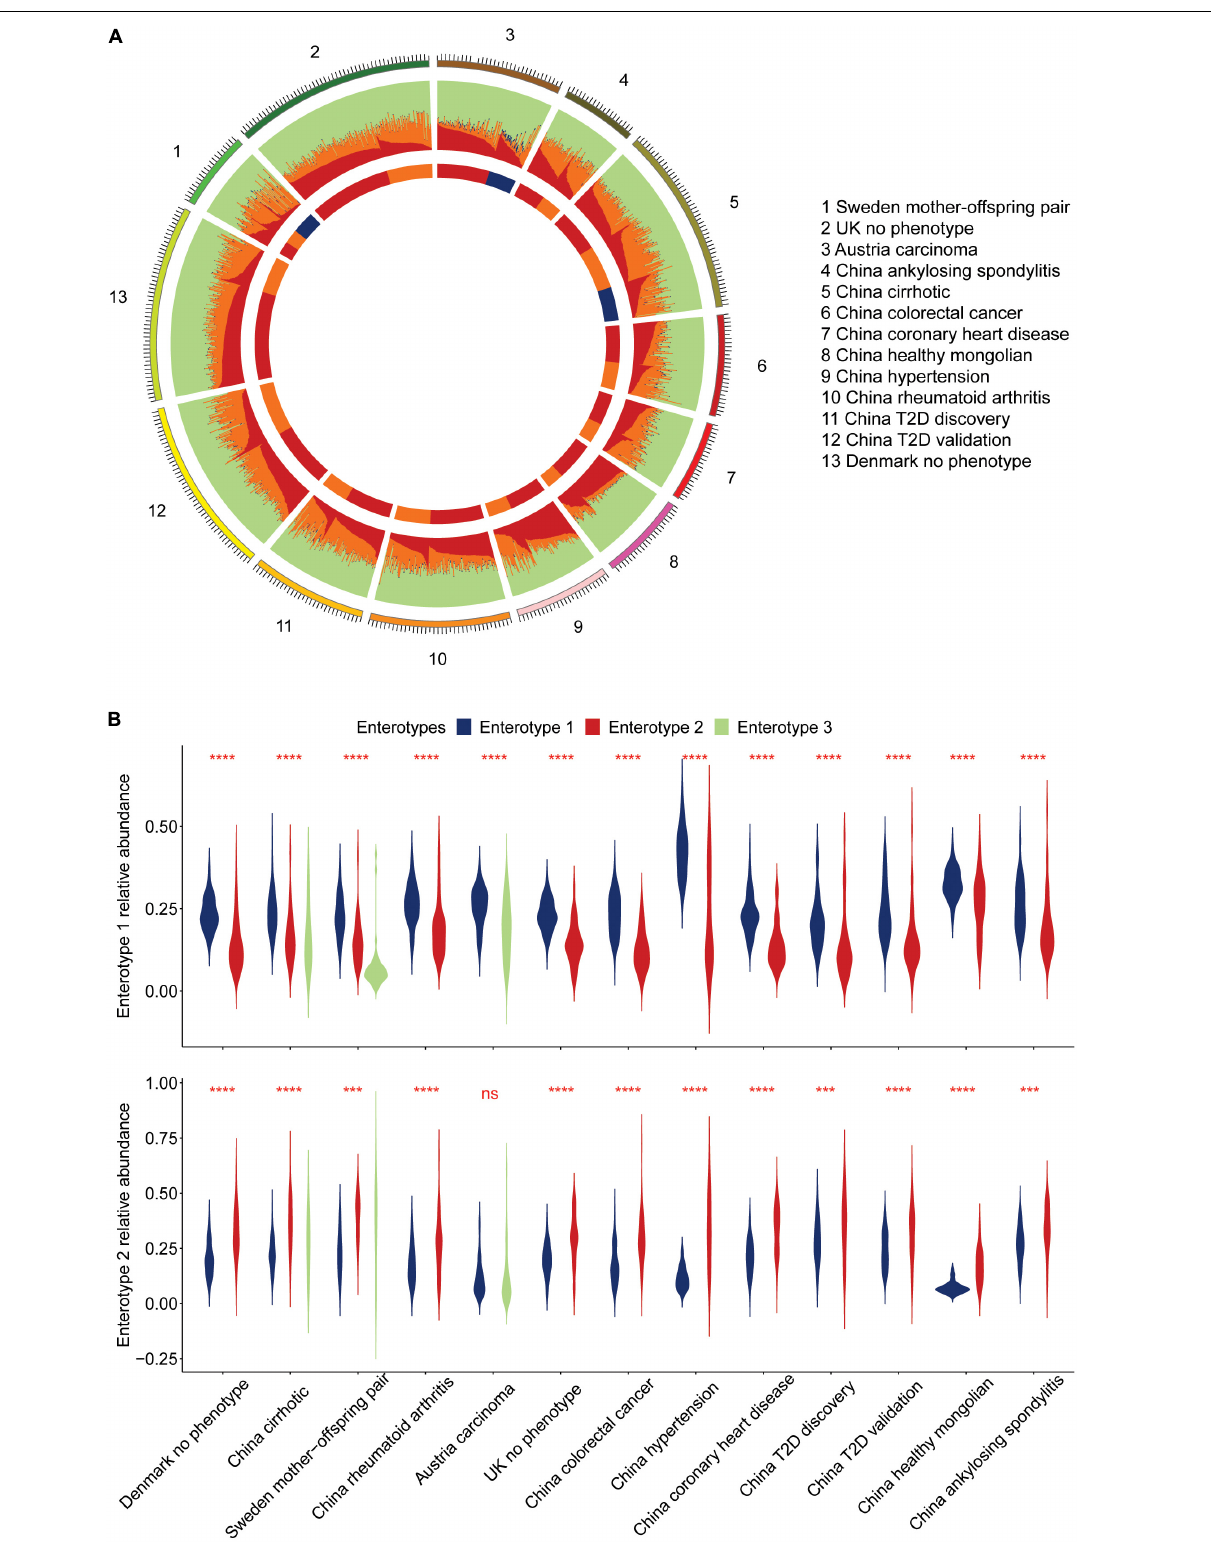
Frontiers in Microbiology |